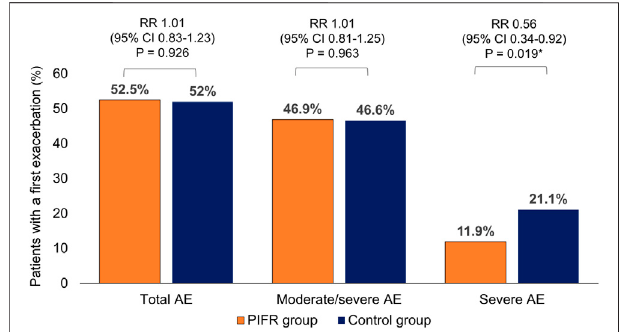
FIGURE 3 | Incidence of acute exacerbation of chronic obstructive pulmonary disease within one year among the patients in the PIFR group and control group. AE: acute exacerbation. RR: relative risk. CI: con fi dence intervals.